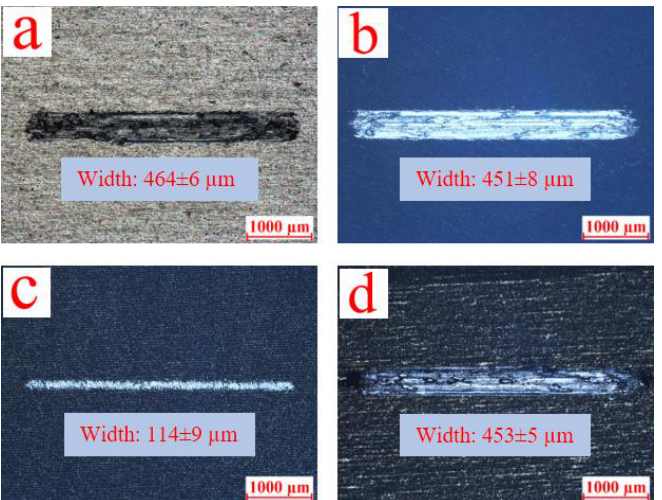
Figure 7. The optical surface images of worn scars on the NiTi alloy with and without laser nitriding ( a ) untreated (sample S-1) ( b ). Laser nitriding with scanning speed of 80 mm/s and frequency of 100 kHz at room temperature (sample S-2) ( c ) laser nitriding with scanning speed of 40 mm/s, and frequency of 200 kHz at room temperature (sample S-3). ( d ) Laser nitriding with a scanning speed of 40 mm/s and a frequency of 200 kHz at low temperature (sample S-4).